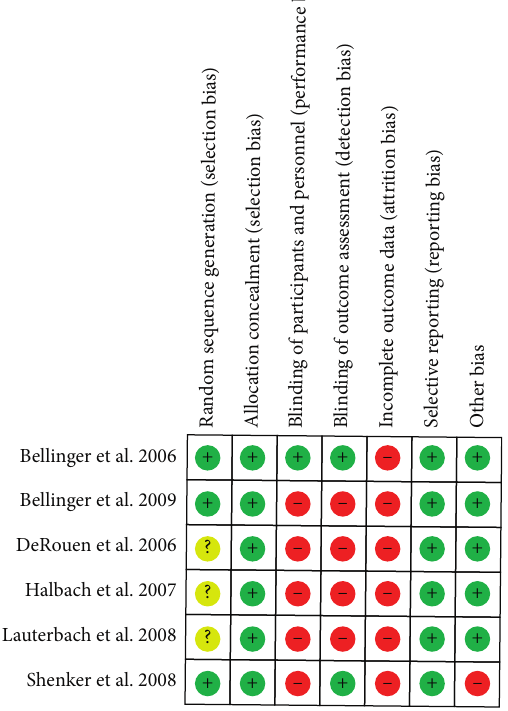
Figure 2: Risk of bias summary across all included